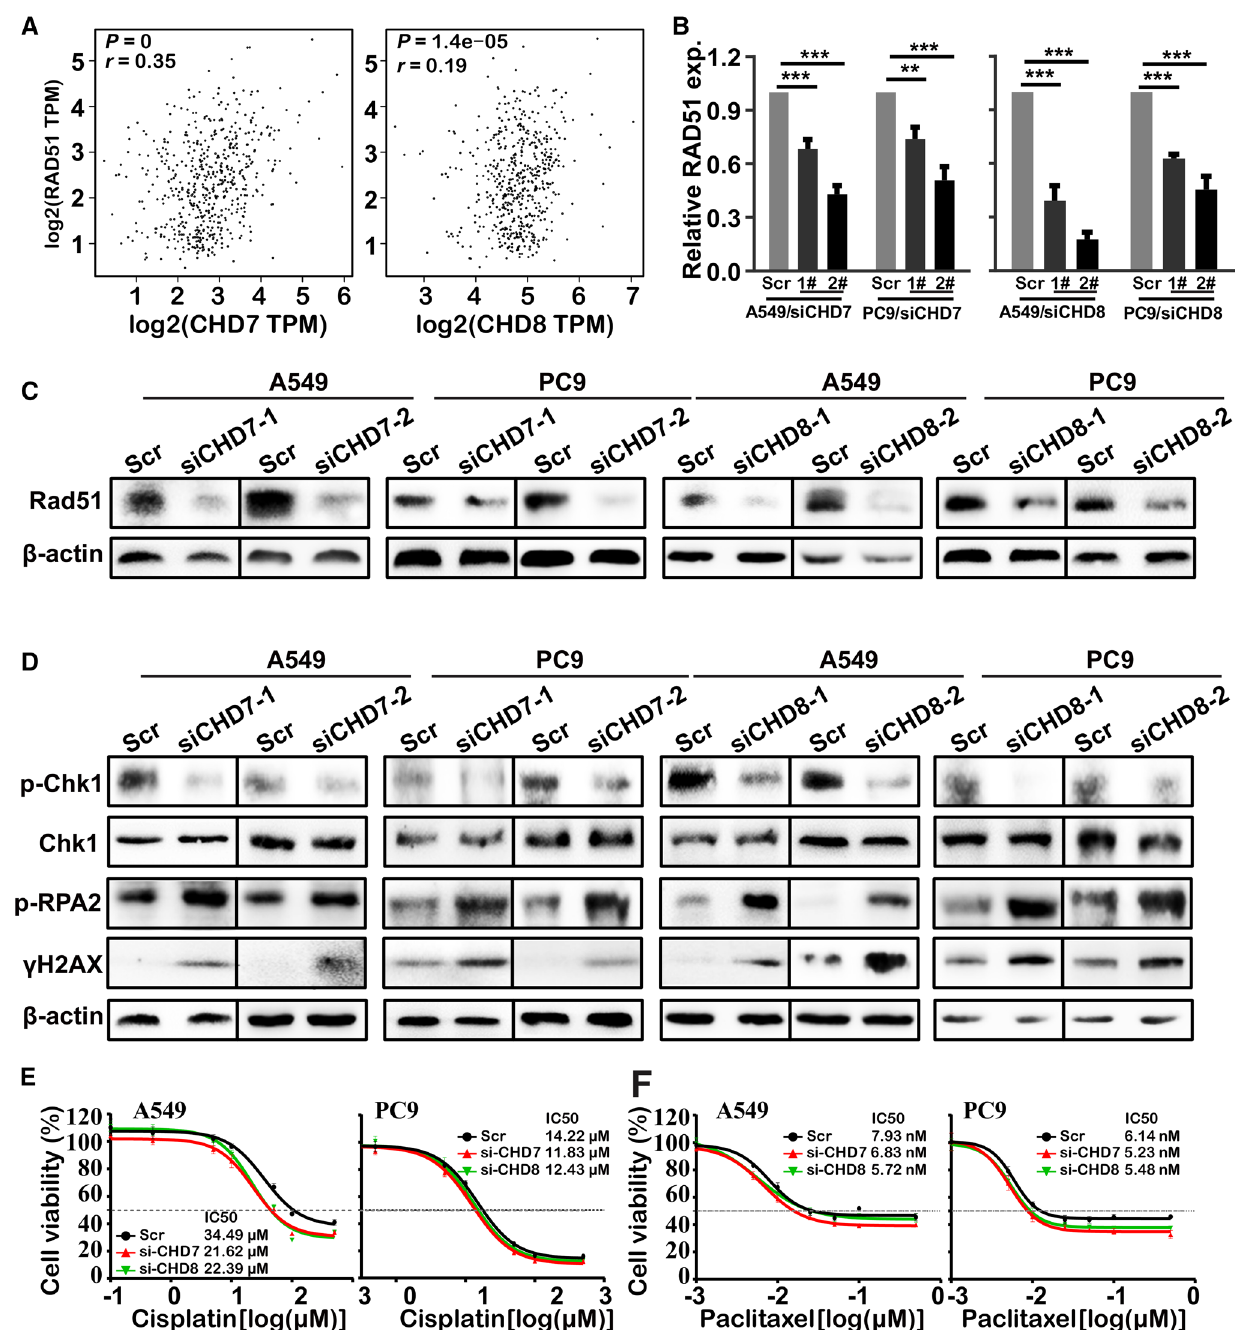
Fig. 7 The effect of Chd7/8 knockdown on the DNA damage response in lung adenocarcinoma. A Pearson correlation analysis showing the correlation between CHD7/8 expression and RAD51 expression in LUAD; B RT–qPCR analysis of RAD51 upon CHD7 and CHD8 silencing; C , D Western blot analysis of Rad51 (C), γH2AX and p-chk1 (D) proteins upon depletion of CHD7 and CHD8; E , F Growth inhibition curves of cis- platin ( E ) and paclitaxel ( F ) in A549 and PC9 cells with CHD7 and CHD8 knockdown. The cell viability was assessed by the CellTiter-Glo assay. The IC50 values were determined from the sigmoidal dose–response curves using GraphPad PRISM6